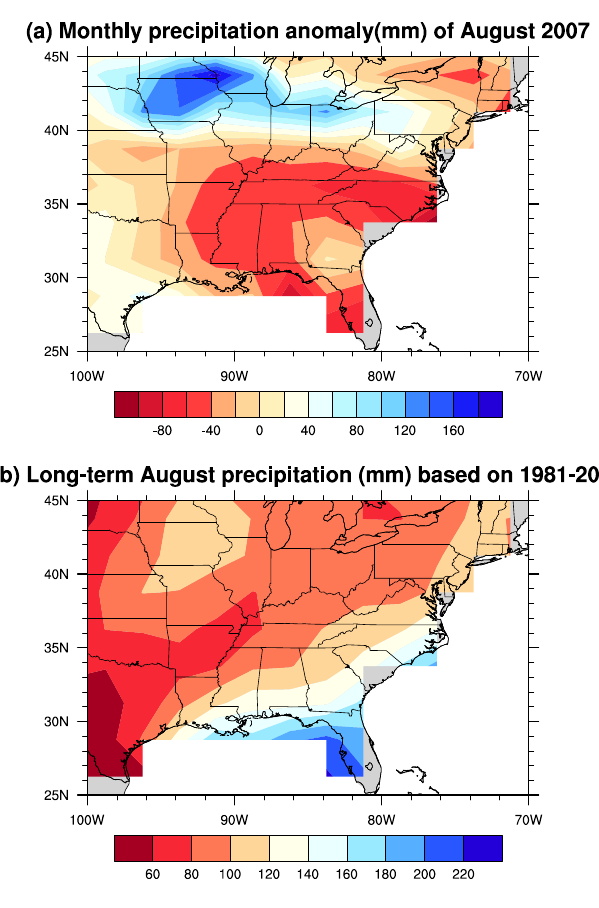
Figure 4. Observed precipitation anomaly of August 2007, as shown in ( a ), apart from the long term mean August precipitation as shown in ( b ). The contour interval is 20